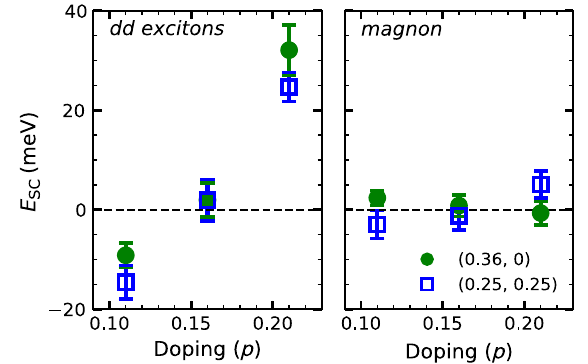
FIG. 5. Doping dependence of the superconductivity-induced change of the average dd exciton and magnon energies. The momentum values are (0.36, 0) (green circles) and (0.25, 0.25) (blue squares). The error bars are extracted from the fit